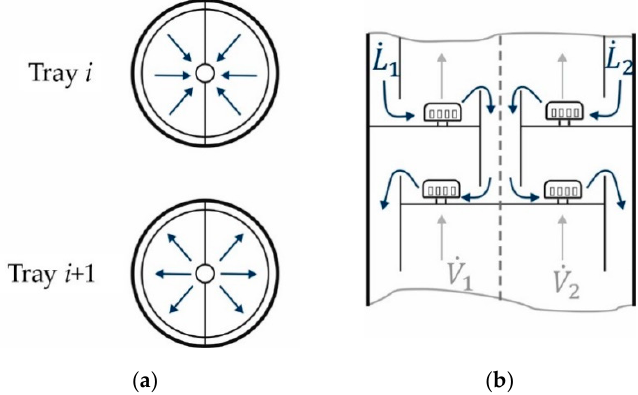
Figure 6. Schematic representation of a segmented column shown for two segments in one column shell, as top view ( a ) and side view ( b ), for two stages located above each other [95]. Figure 6 shows the concepts for two consecutive trays as a top (left) and side view (right). The grey dotted line indicates the partition wall along the total height of the column. In this case two segments are built-up within the column, leading to two separate liquid flows ( 𝐿(cid:4662) (cid:2869) and 𝐿(cid:4662) (cid:2870) ) and two vapor flows ( 𝑉(cid:4662) (cid:2869) and 𝑉(cid:4662) (cid:2870) ). In this example the liquid flows alternating from the exterior area of the tray to the center (tray i ), and from the center to the exterior area of the tray (tray I + 1). These altering flow directions are known from radial flow